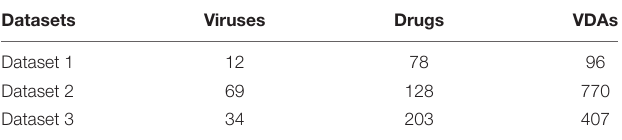
TABLE 1 | Statistics for three VDA